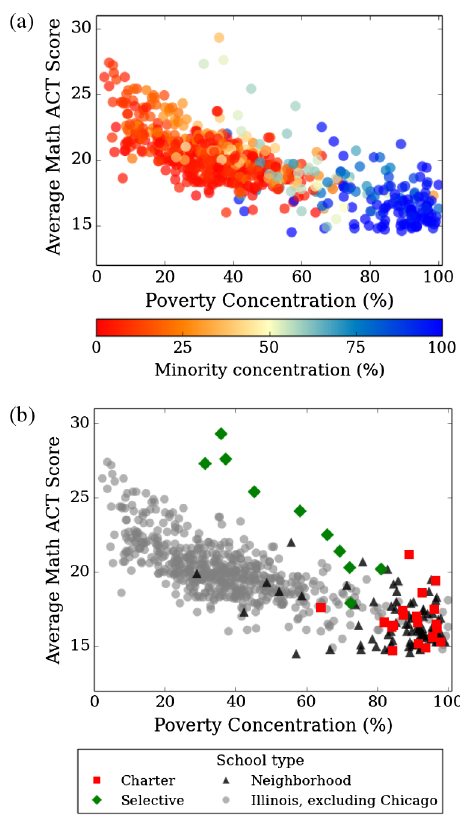
FIG. 5. Average math ACT score of each Illinois school. (a) Math ACT score as a function of poverty concentration. The color of the points indicates the percent of minority